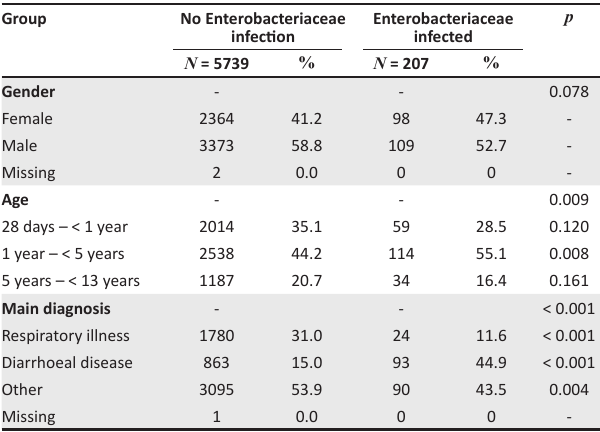
TABLE 1: Age, gender, main diagnosis and Enterobacteriaceae infections. Group